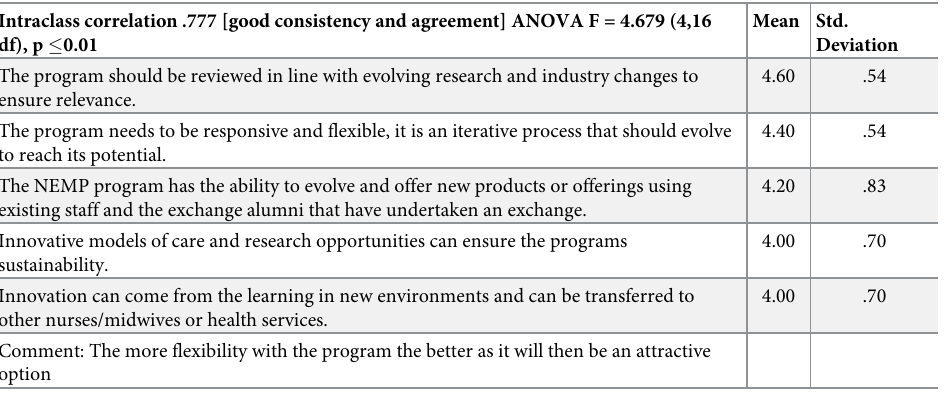
Table 11. Rate how you regard the following components in regard to INNOVATION influencing the success and sustainability of the NMEP program. Intraclass correlation .777 [good consistency and agreement] ANOVA F = 4.679 (4,16 df), p � 0.01